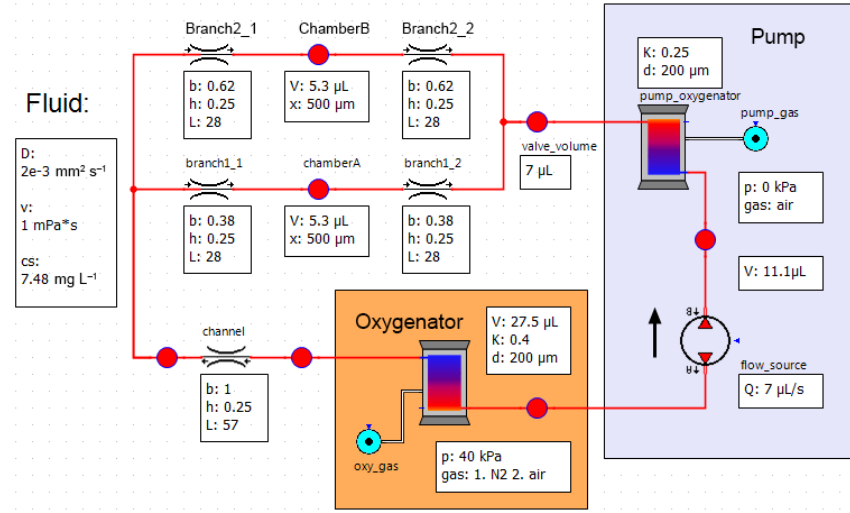
Figure 6. SimulationX model of oxygen transport in the microfluidic system.